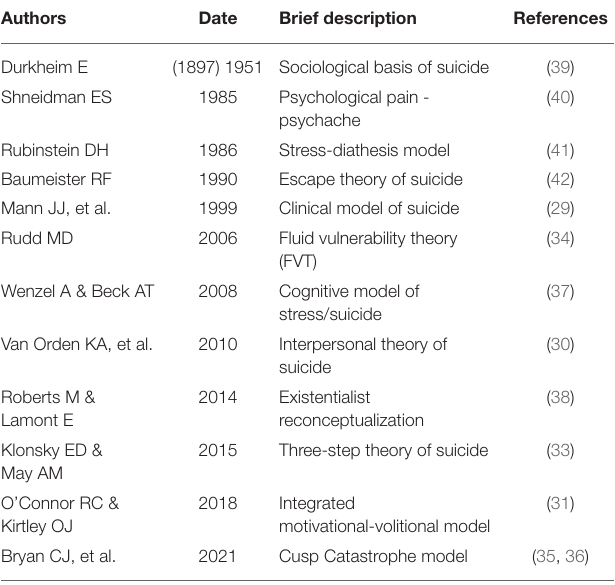
TABLE 1 | Summary of notable theories of